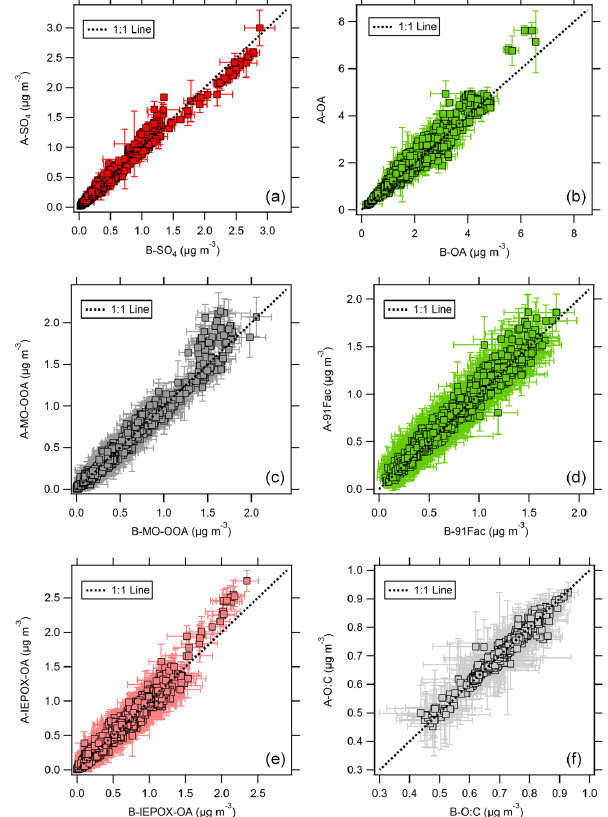
Figure 4. Scatterplots of above-canopy (A) and below-canopy (B) hourly averaged values for (a, b) SO 4 and total OA, (c, d) MO- OOA and 91Fac, and (e, f) IEPOX-OA and campaign O:C. The three-way valve switched between the two inlets at 10min intervals, so 30min averaged mass concentrations allow for a comparison of both inlets on the same time basis. Above-canopy values are plotted on the y axis of each plot, and below-canopy values are plotted on the x axis of each plot. Averages are shown with squares; whiskers represent 1 standard deviation from the mean. For reference, a 1:1 line is shown with each plot. Outliers on the O:C plot correspond- ing to periods of precipitation were